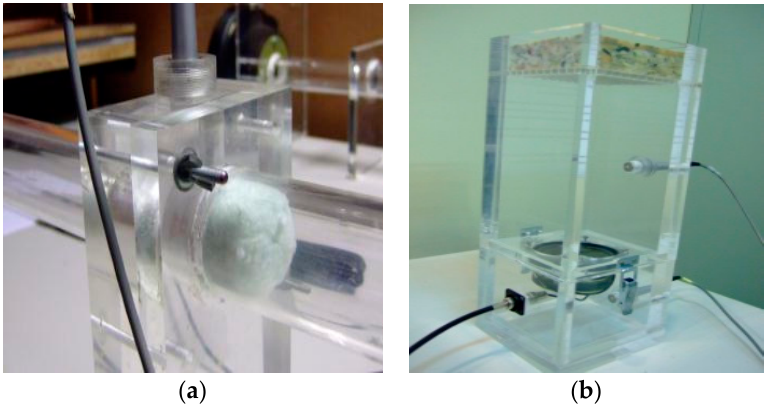
Figure 2. Airflow measurement systems. ( a ) Ingard & Dear’s indirect method; ( b ) Dragonetti et al. method.